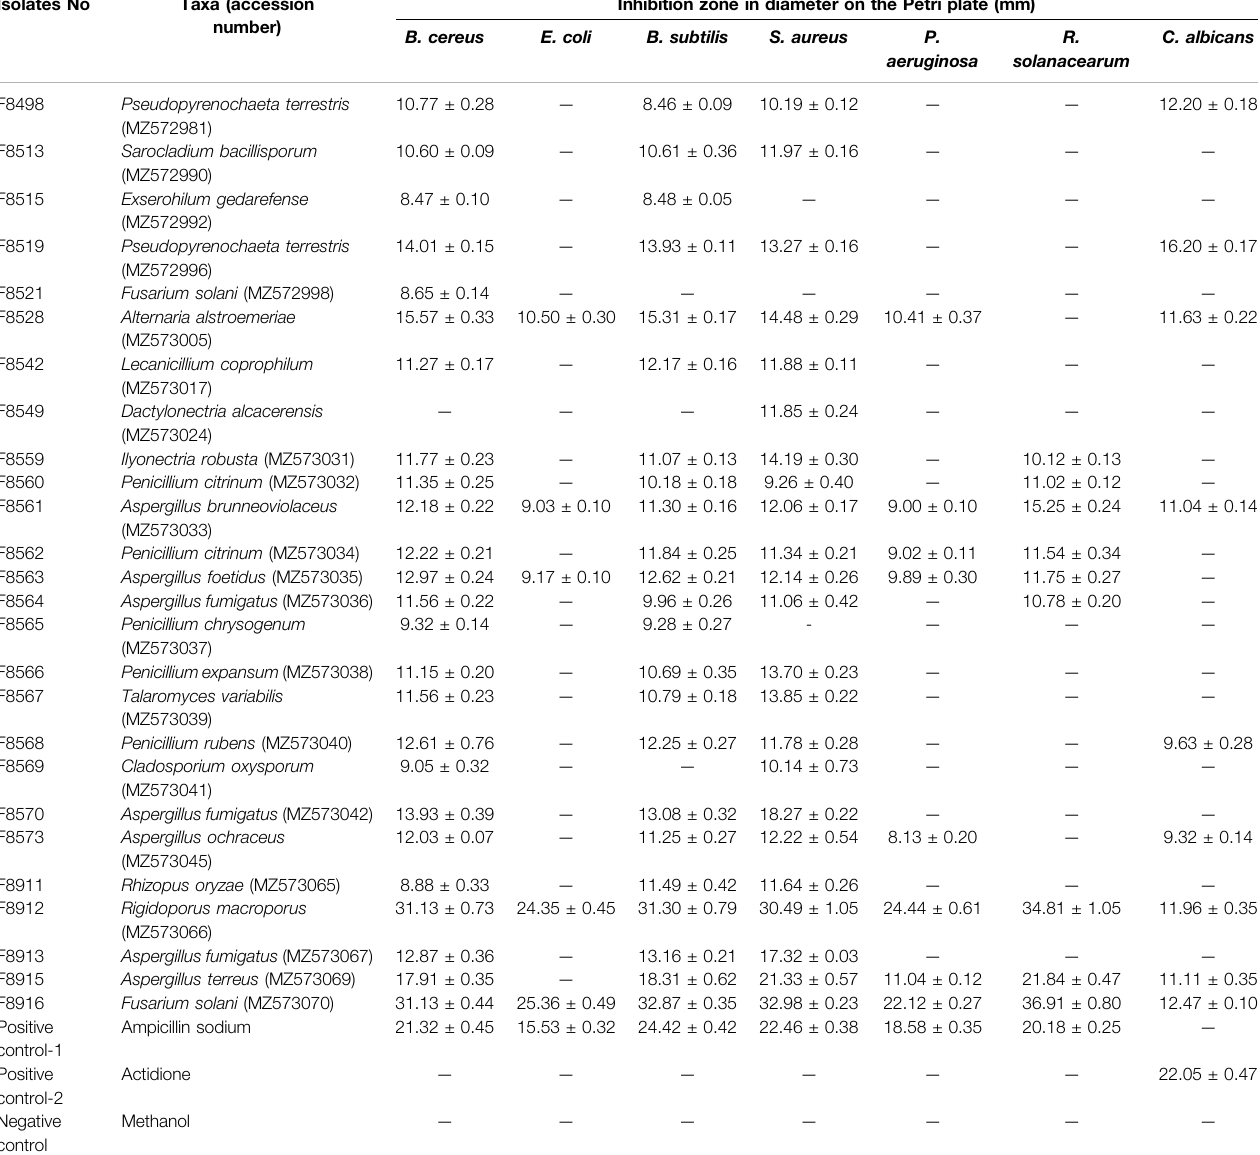
Inhibition zone in diameter on the Petri plate